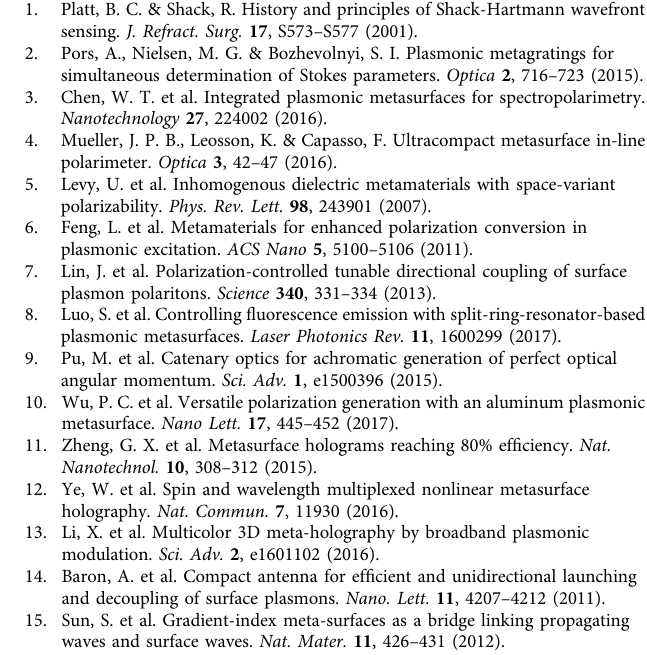
wavelengths. In our demonstration, we have used 1550 nm.